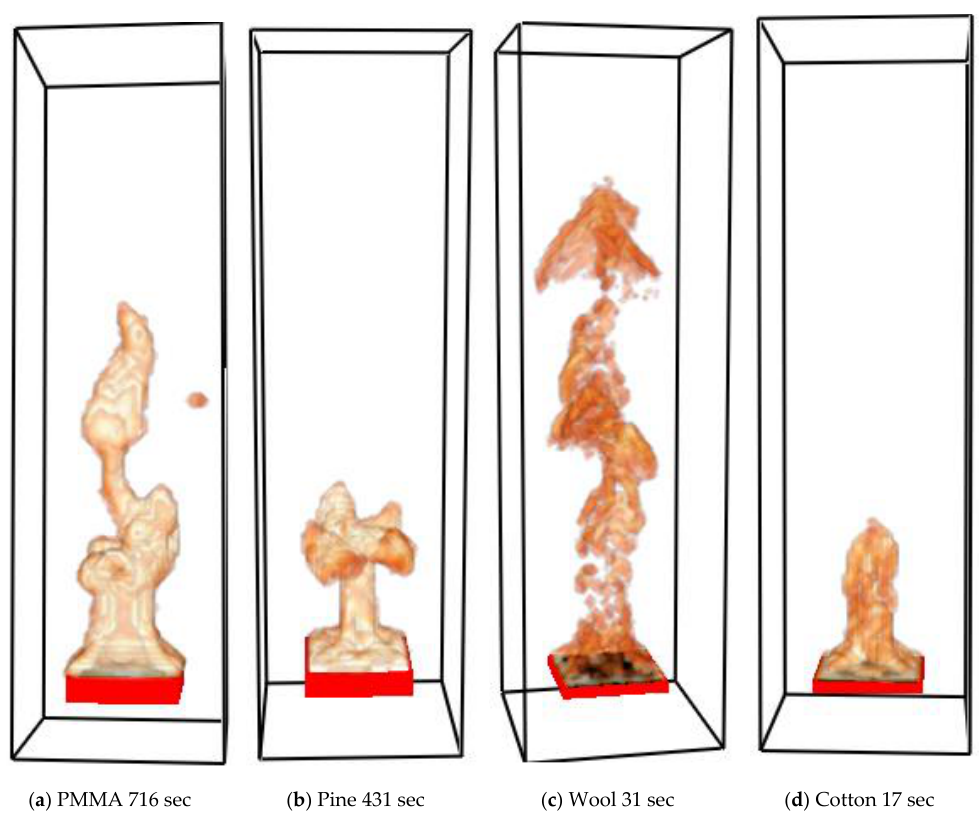
Figure 5. Modelled flaming combustion of four materials within domains. Visualization is done